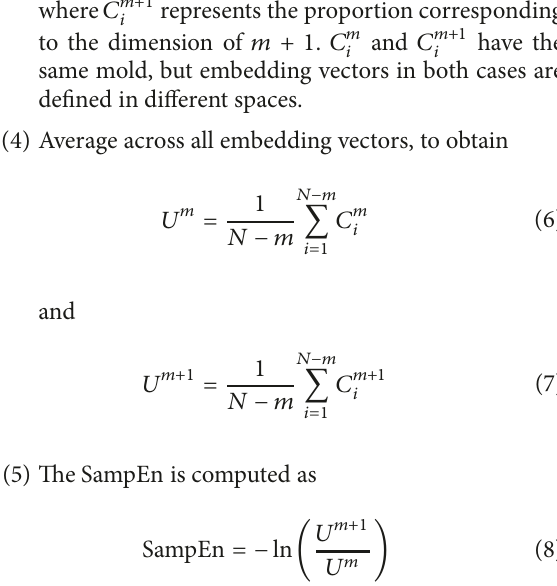
Figure 1: Averaged spectra of IMFs (1-9) obtained from 50 realiza- tionsofeight-channelwhiteGaussiannoiseviaMEMD.Reproduced from